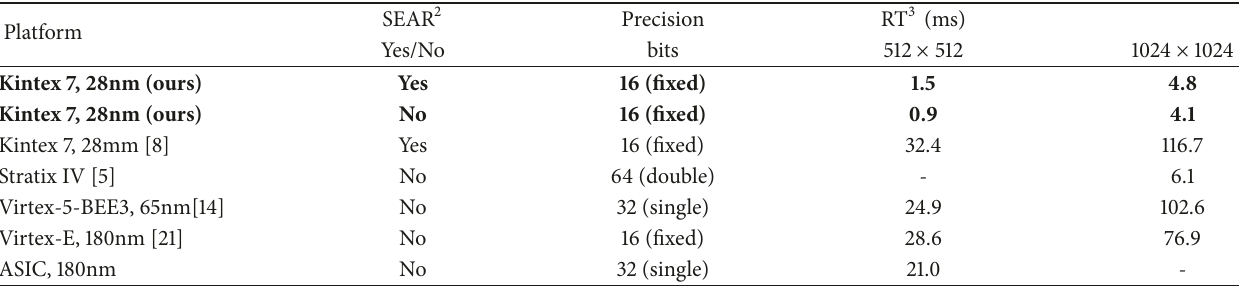
Table 2: Comparison of OPSD 1 2D FFT with regular RCD-based implementation.